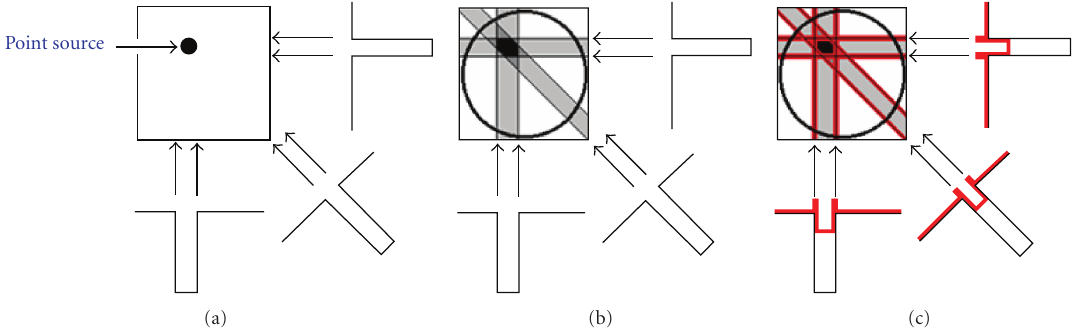
Figure 1: A simple representation of filtered back projection. (a) Acquisition of three projections. (b) Backprojected projections. (c) Filtered backprojected